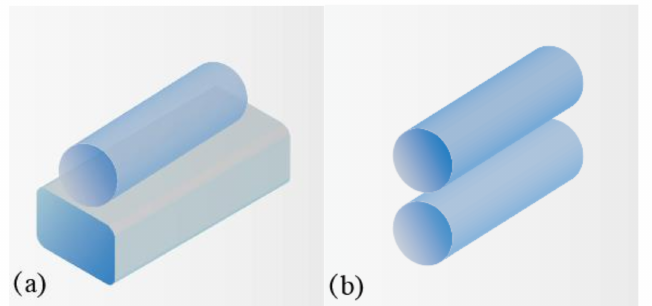
Figure 8. ( a ) cylinder-rectangle waveguide schematic diagram; ( b ) double-cylinder waveguide schematic diagram.